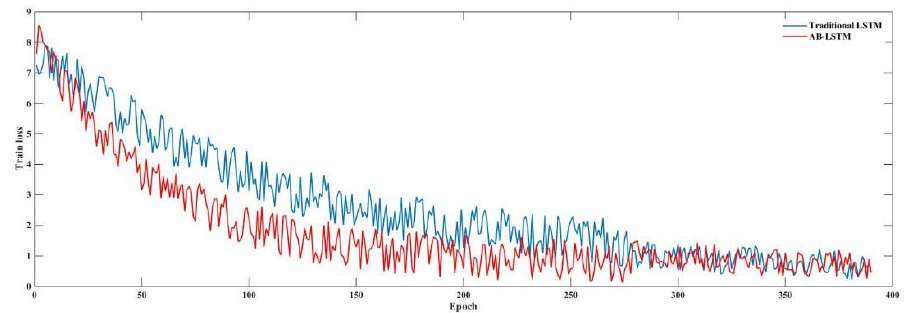
Figure 7. Loss curves of traditional long short-term memory (LSTM) and attention-based LSTM (AB-LSTM).